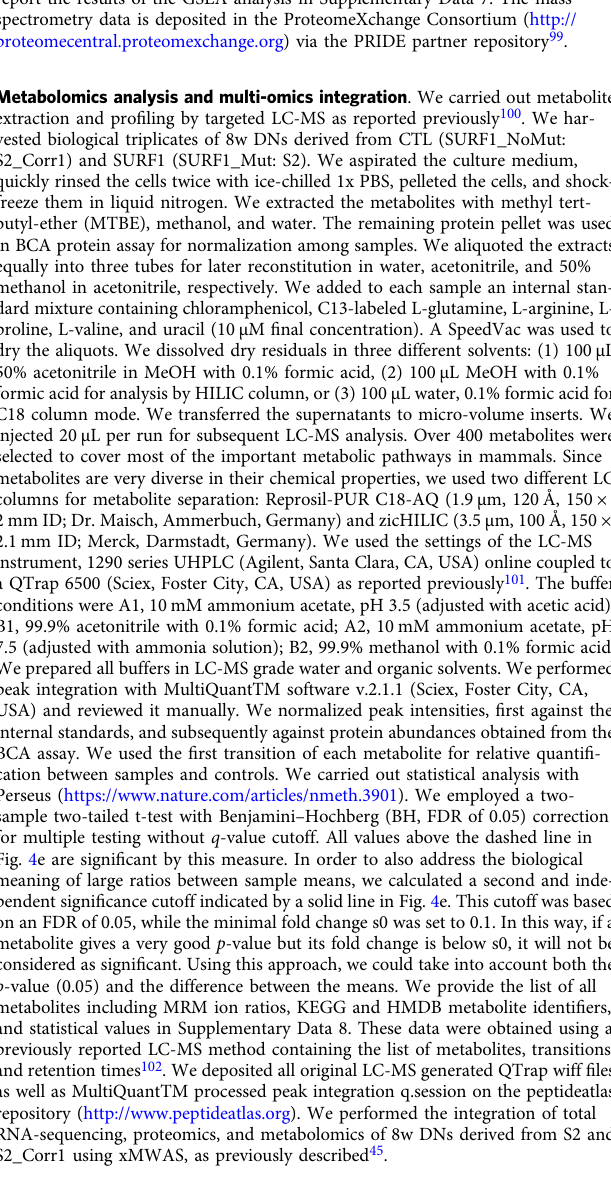
Fig. 4e are signi fi cant by this measure. In order to also address the biological meaning of large ratios between sample means, we calculated a second and inde- pendent signi fi cance cutoff indicated by a solid line in Fig. 4e. This cutoff was based on an FDR of 0.05, while the minimal fold change s0 was set to 0.1. In this way, if